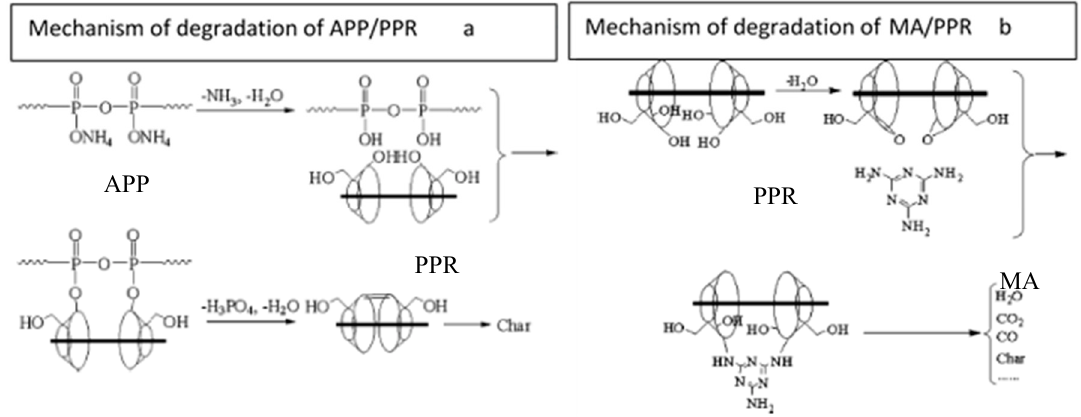
Scheme 1. Mechanism of degradation of amine/ammoniumpolyphosphate–cross-poly(ethylenimine)/ Mechanism of degradation of amine/ammoniumpolyphosphate–cross-poly Polypseudorotaxane (APP/PPR) ( a ) and of melamine/PPR (MA/PPR) ( b ). Adapted with permission (ethylenimine)/Polypseudorotaxane (APP/PPR) ( a ) and of melamine/PPR (MA/PPR) ( b ). Adapted from ref.